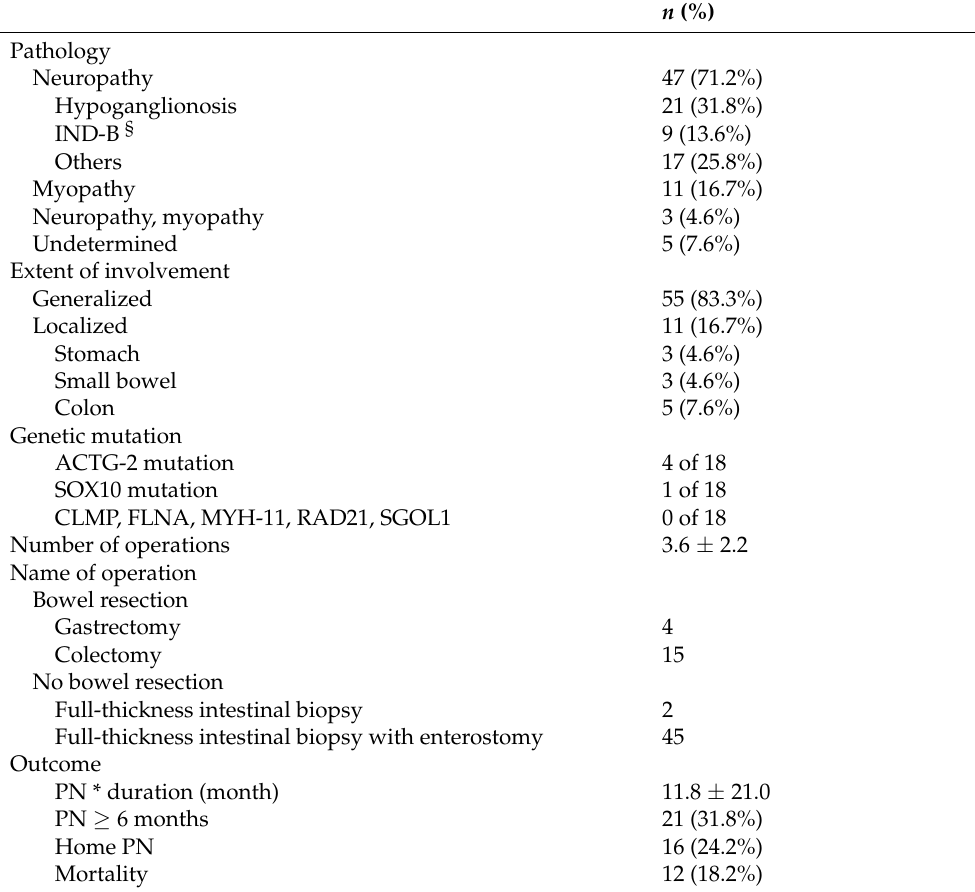
Table 2. Disease characteristics in chronic intestinal pseudo-obstruction patients.